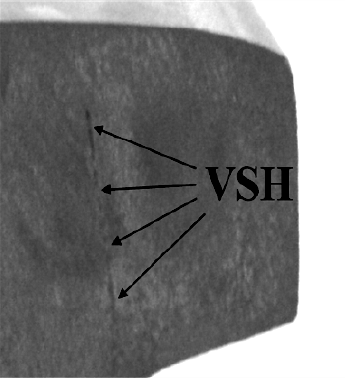
Figura 10: Difetto nel fungo noto come spaccatura verticale (VSH).